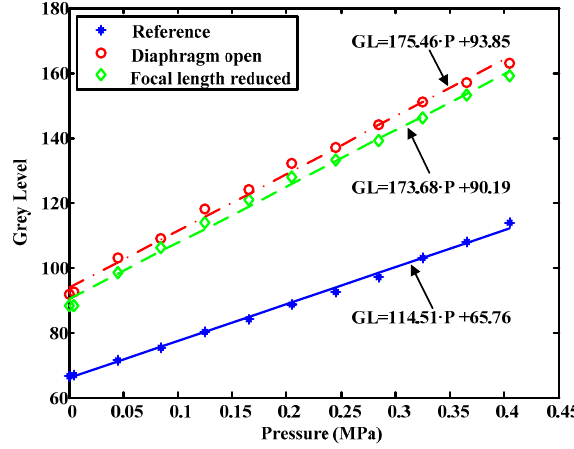
Figure 3. Influence of the diaphragm aperture.